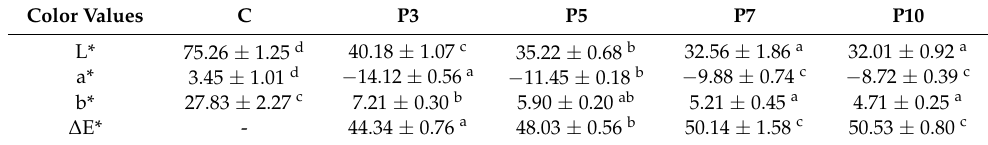
Table 2. Color values in CIE L* a* b* system of the pasta doughs supplemented with spirulina powder. Color Values C P3